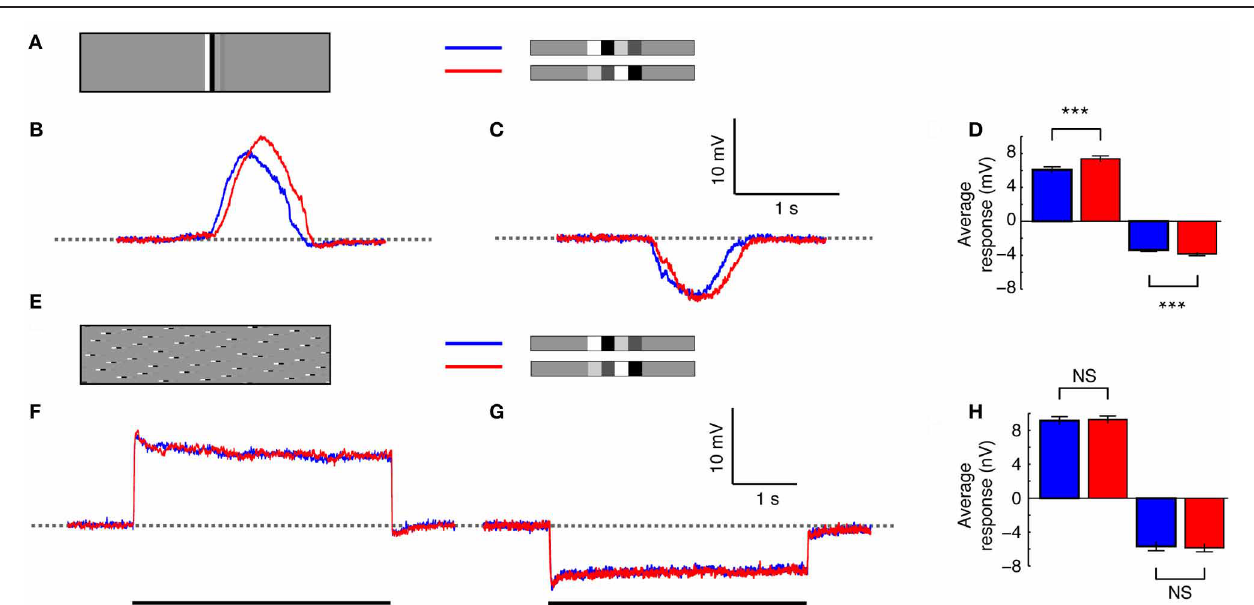
FIGURE 5 | Re-distribution of the stimulus. (A) The doublet pairs presented using the whole-screen mode. Blue indicates the decreasing contrast pair, and red the increasing contrast pair. (B) Intracellular HS neuron response to the doublets as they pass through the receptive field in the preferred direction ( N = 8, n = 125). (C) Intracellular response to the doublets moving in the anti-preferred direction ( N = 6, n = 85). (D) The mean response to the doublets moving in the preferred and anti-preferred direction. ∗∗∗ Indicates a significant difference ( p < 0 . 001, Student’s t- test). (E) The doublet pair broken up into individual pseudo-randomly distributed